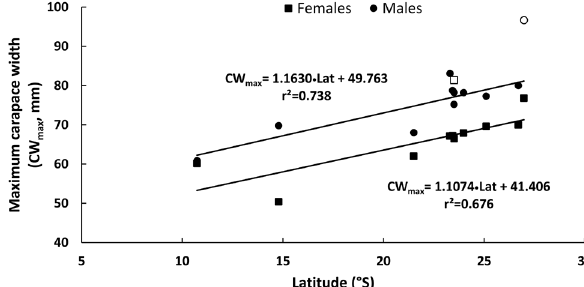
Figure 6. Relationships between maximum carapace width ) for m (CW ) and latitude (Lat) for females and males of Hepatus max pudibundus along the Brazilian coast. The white square corresponds to females off São Paulo (Lima et al., 2014a) and the white circle to males off Santa Catarina (Sardá et al. ,